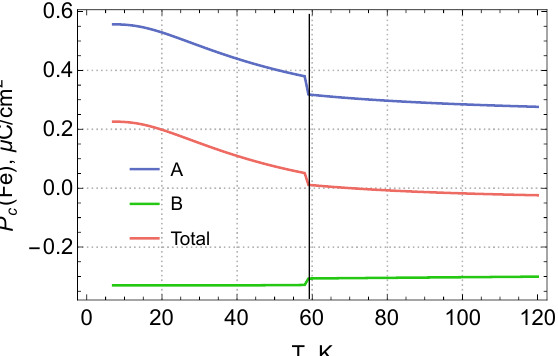
Figure 3. Calculated contributions to the electric polarization due to iron ions in the PM and AFM ( T < 60 K) phases.